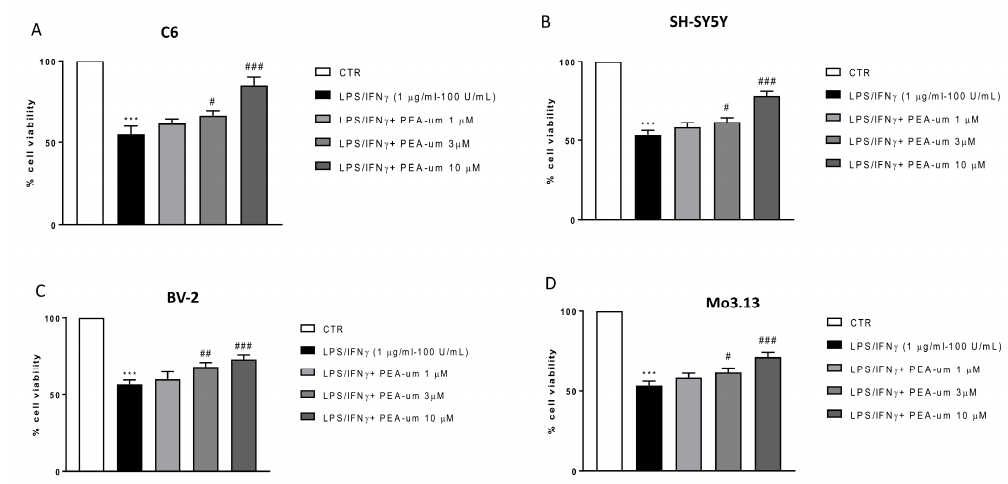
Figure 2. Anti-inflammatory e ff ects of PEA-um in both neuronal and non-neuronal cell lines following LPS / IFN γ -stimulation. Cell vitality was assessed following 24 h treatment with LPS (1 µ g / mL) and INF- γ (100 U / mL) and di ff erent concentrations (1, 3, and 10 µ M) of PEA-um. PEA-um at 3 µ M and 10 µ M significantly locked damage caused by LPS / INF- γ in all cell lines ( A – D ). Particularly, in BV-2 microglial cells, the e ff ects of PEA-um 3 µ M were almost comparable to those of treatments at 10 µ M ( C ). PEA-um 1 µ M is unable to protect against LPS / INF- γ induced damage, in all cells object of the study ( A – D ). Data are representative of at least three independent experiments. *** p < 0.001 versus CTR # p < 0.05, ## p < 0.01 and ### p < 0.001 versus LPS / INF- γ